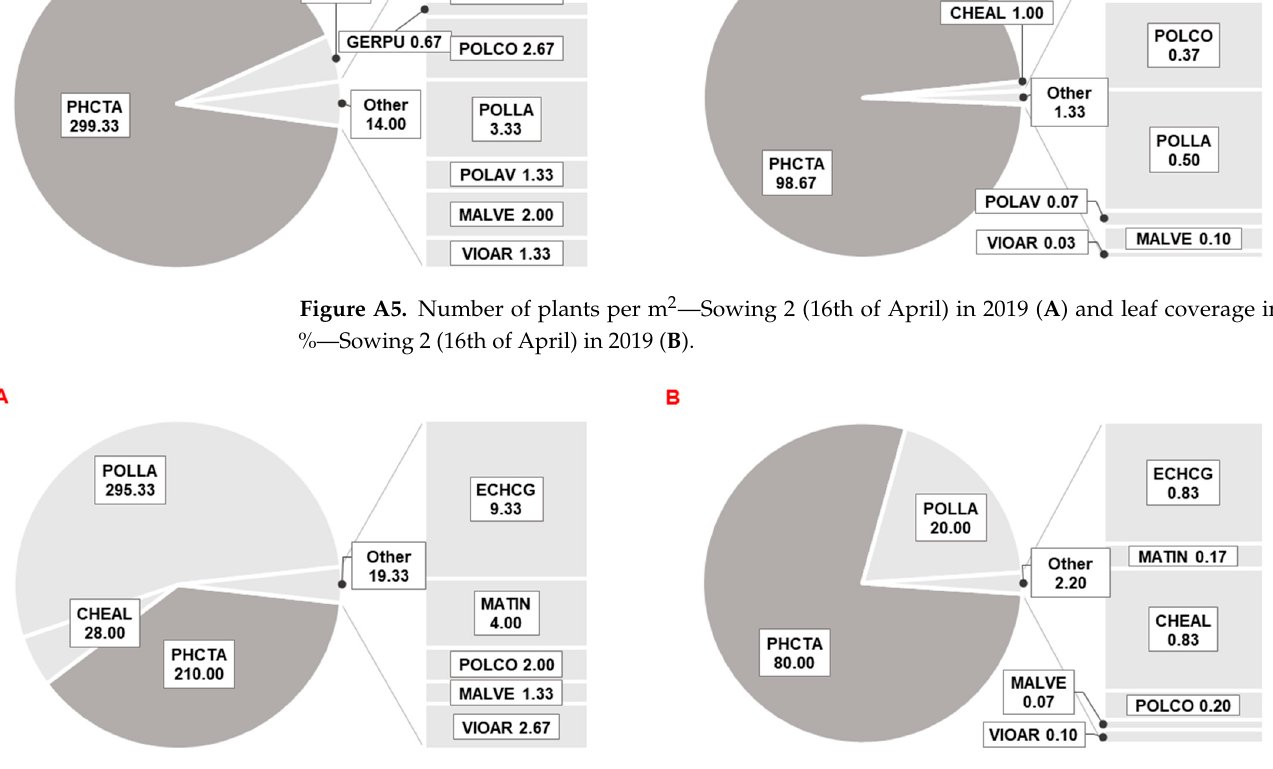
Figure A6. Number of plants per m 2 —Sowing 3 (7th of May) in 2019 ( A ) and leaf coverage in %—Sowing 3 (7th of May) in 2019 ( B ).